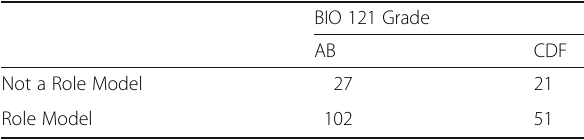
Table 4 Student frequencies by final course grade and student consideration of peer leaders as role